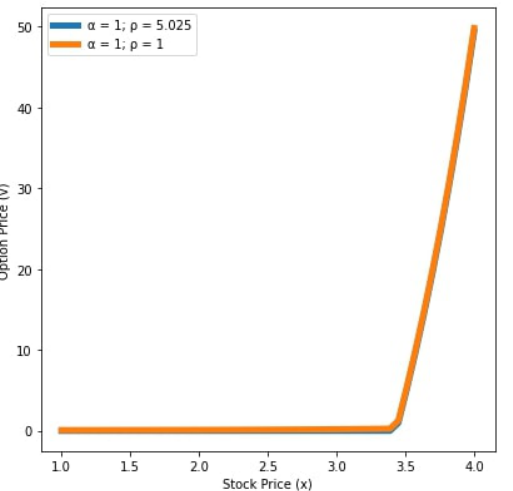
Figure 7. Values of the options for α = 1 and ρ > 1, t = 0.5 years with y = 1.6093.